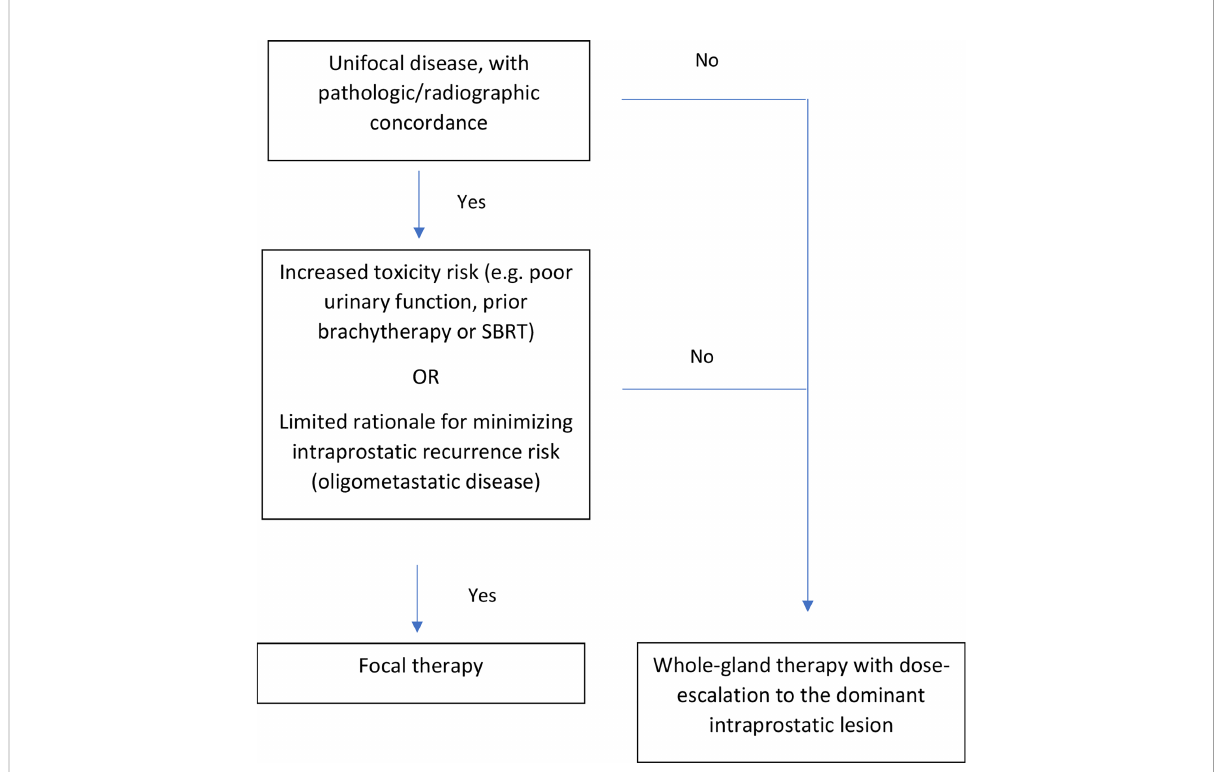
FIGURE 1 Risk-adaptive approach for focal versus whole-gland salvage therapy for radiorecurrent prostate